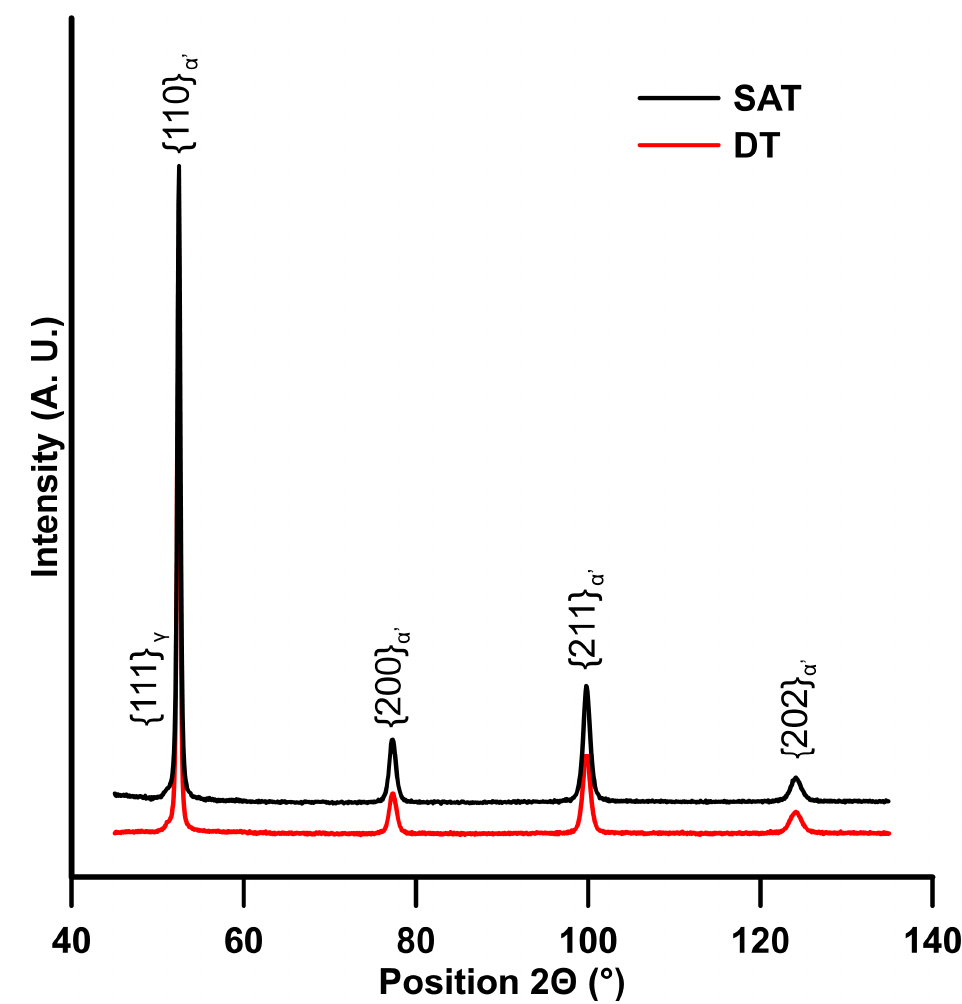
Figure 5. Inverse pole figure (IPF), misorientation angle distribution, and geometrically necessary dislocation density maps (GND) for DT and SAT materials. Grain orientation spread (GOS) map with color distribution of recrystallized (blue) and non-recrystallized (red) grains, and the transition grains between these states are yellow.